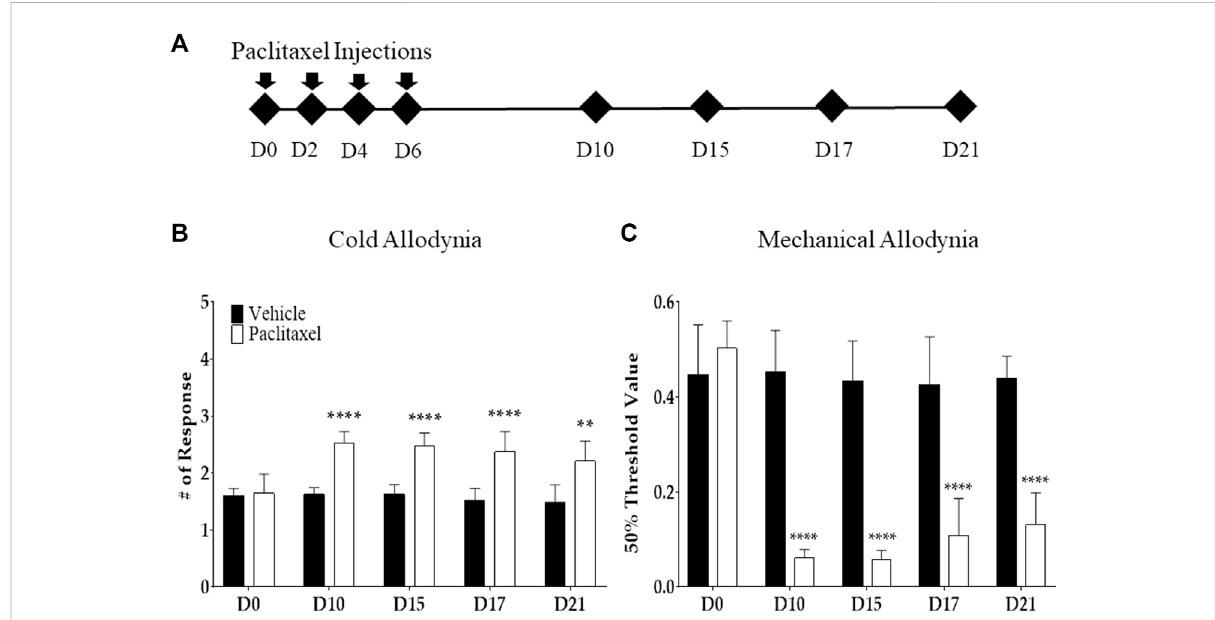
FIGURE 1 Effects of multiple paclitaxel injections on mice. Behavioral tests to assess allodynia were performed before (time point zero) and after four i.p. injections of 2 mg/kg of paclitaxel (days 0, 2, 4, and 6; an accumulative dose of 8 mg/kg). The timeline of behavioral tests (A) and the behavioral responses to cold (B) and mechanical (C) stimuli. Cold and mechanical stimuli were provided via the acetone drop and von Frey fi lament tests, respectively. A mixed solution of Cremophor EL and ethanol (1:1) was used as the vehicle. N = 8 in each group. ** p < .01 and **** p < .0001 vs. control with two-way ANOVA, followed by Tukey ’ s post-test for multiple